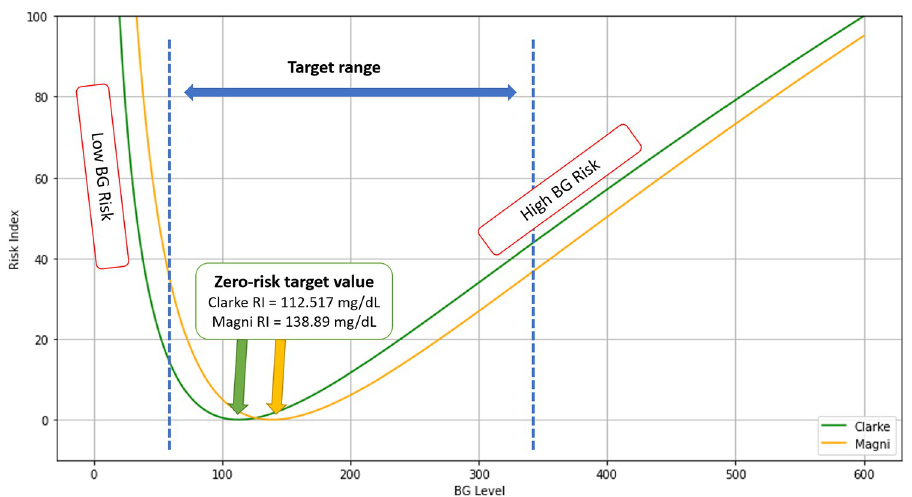
Fig 2. Blood glucose risk index function. Our target value is BG level at 112.517 mg/dL for Clarke RI and 138.89 mg/ dL for Magni RI and having a zero BGRI implies that there is no risk for a patient at this point (Zero-risk). This plot shows graphically this point, including the left and right sides of the zero-risk target value, i.e., LGBI and HBGI, respectively. BG level at 70-350 mg/dL is considered as the target